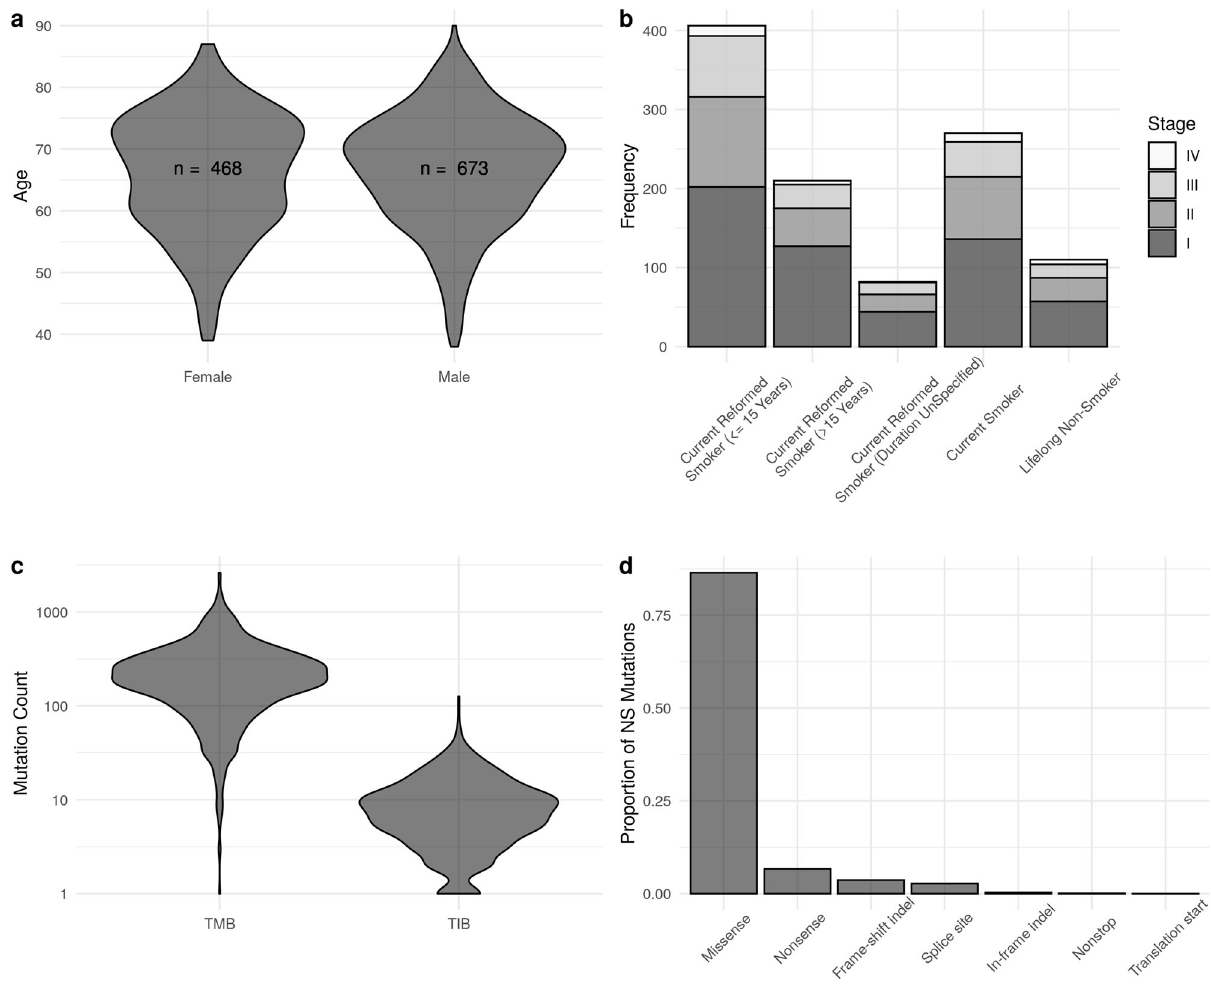
Fig. 1 Population data for the clinical cohort in Campbell et al. NSCLC dataset 20 . a Violin plots of age for patients, strati fi ed by sex. b Stacked bar chart of patients' smoking histories, shaded according to cancer stage diagnosis. c Violin plot of the distribution of TMB and TIB across training samples. d The relative frequency of different non-synonymous mutation